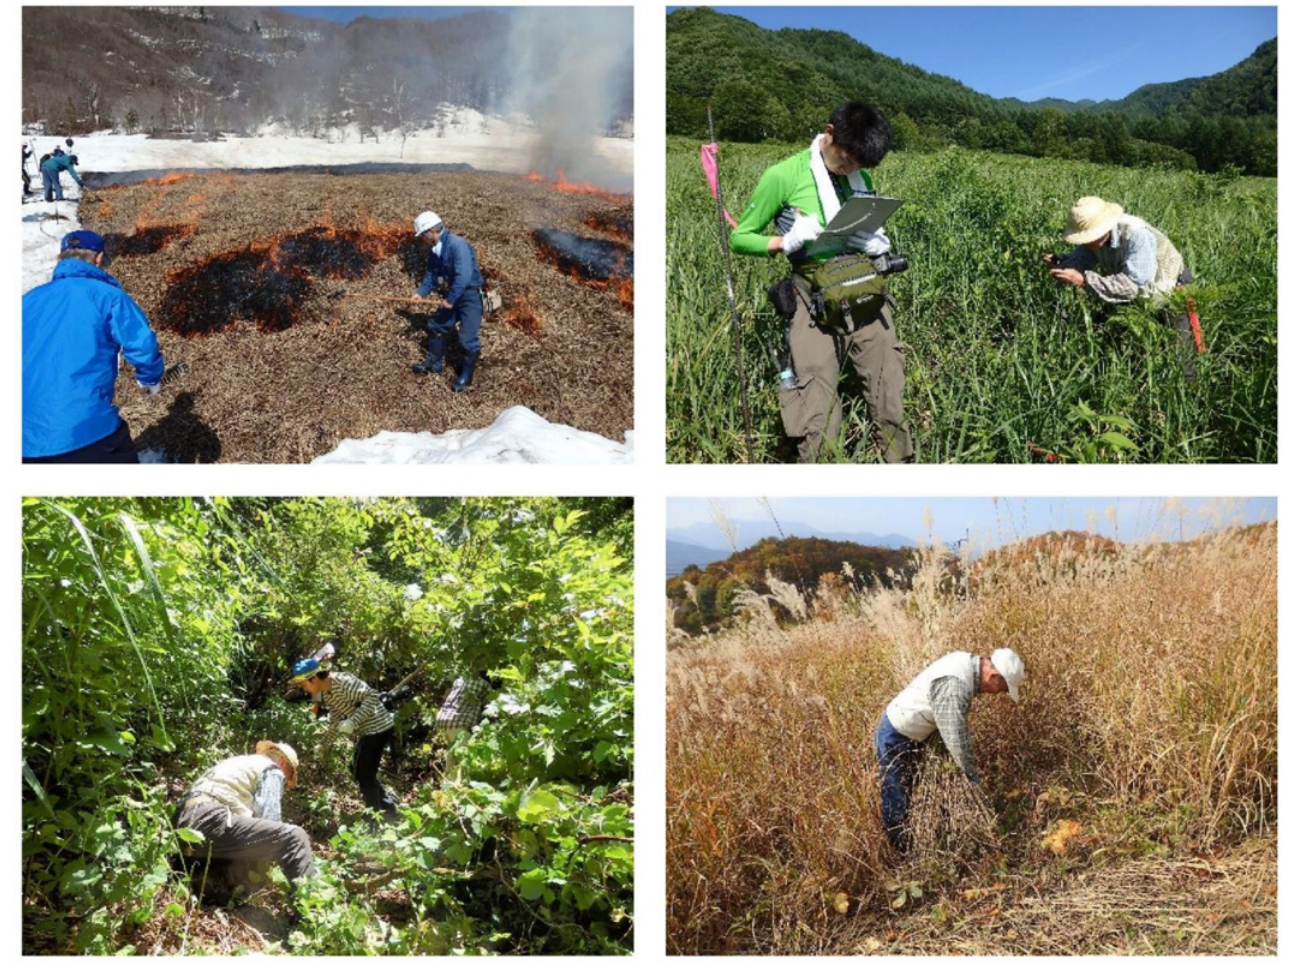
Figure 3. Image showing activities of FCS. These pictures were taken in